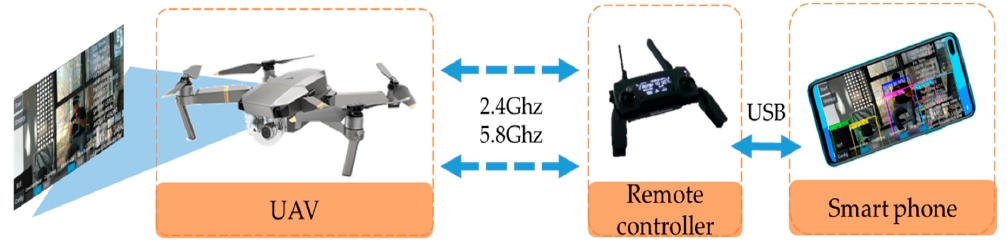
Figure 4. Data flow chart of the system.